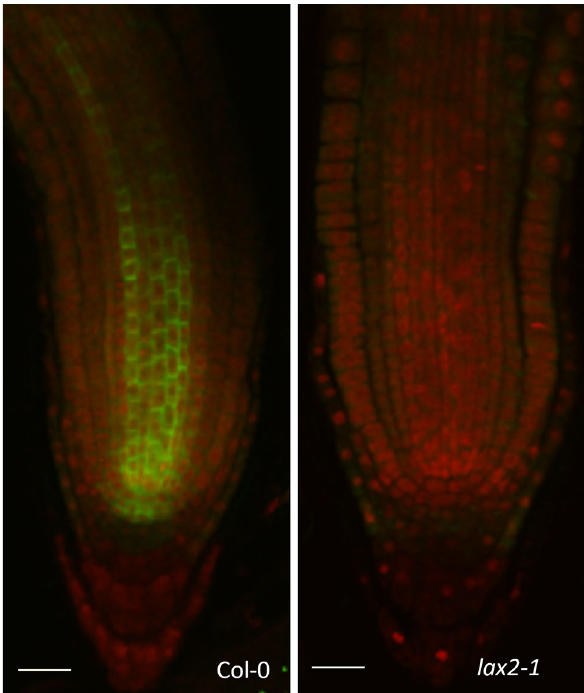
Figure 2. C-terminal antipeptide LAX2 antibody detects strong signal in wildtype Columbia (but not lax2 mutant) roots upon immunolocalization. Affinity purified LAX2 anti peptide antibody was used for in situ immunodetection of LAX2 (green) in 4-day old wild type Columbia or lax2 mutant roots. Primary and Alexafluor 488 coupled secondary antibodies were used at 1:200 dilutions. Seedlings were counter stained using propidium iodide (red). Scale bar 20